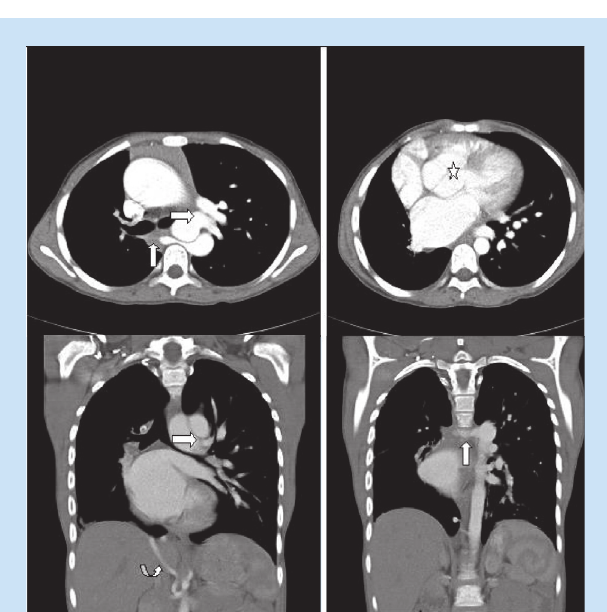
Fig. 2. CT angiogram demonstrates the left ( ) as well as the hypo- plastic right pulmonary artery ( ) originating from the aortic arch. Note the overriding arterial trunk ( ) as well as the aberrant right pulmonary artery (